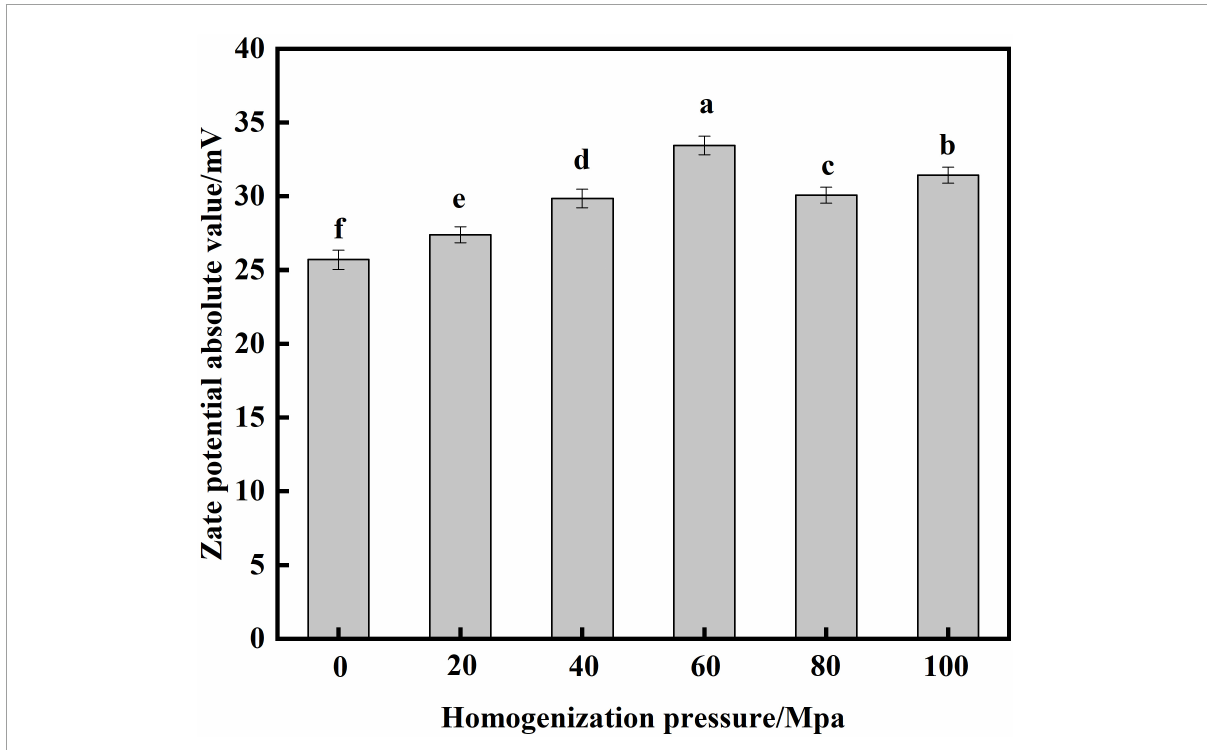
FIGURE3 Effects of high-pressure homogenization (HPH) on the zate potential of enzymatic hydrolysis soybean protein concentrate (SPC).